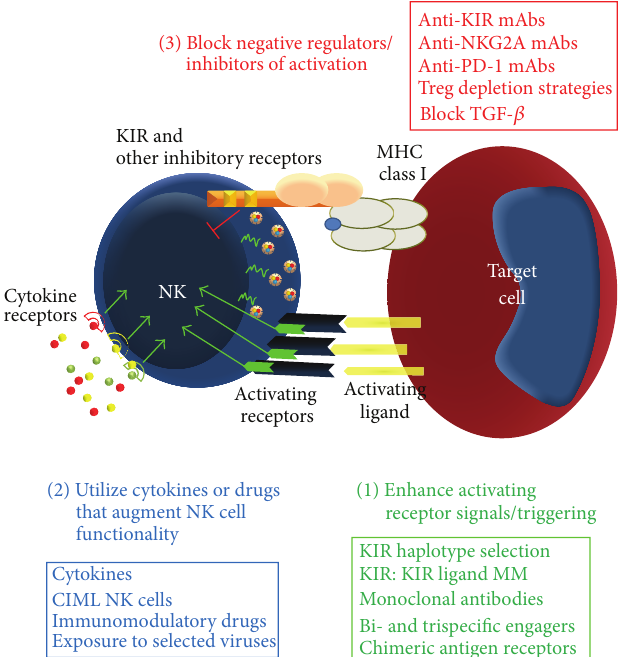
Figure 1: General strategy to optimize NK cell immunotherapy. A three-tiered approach to comprehensively modify NK cells for optimal antitumorresponses.(1)EnhanceNKcellrecognitionandtriggeringwhileprovidingenhancedspecificity,(2)augmentfunctionalstatususing cytokines, immunomodulatory drugs, or prior viral infection, and (3) remove inhibitory signals that include inhibitory KIR/NKG2A/PD-1, block Treg mediated regulation, and block NK cell suppressive